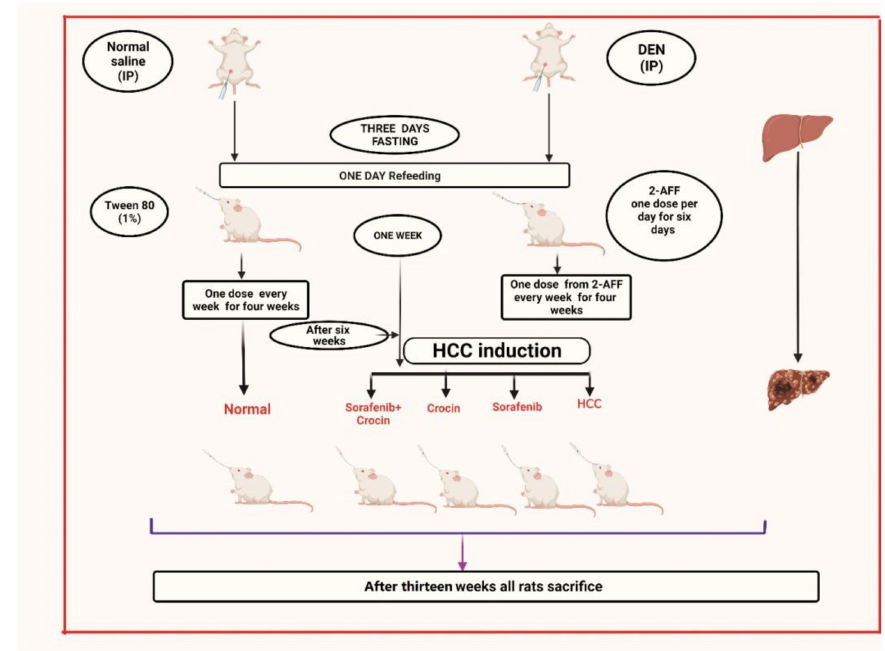
Figure 1. Schematic representation of the experimental setup followed for HCC induction and treatment. The body weights of rats were weekly recorded. Ratio of total body weight changes (%) = (Final weight–Original weight)/Original weight × 100. Liver index (%) = Liver weight/Final body weight ×